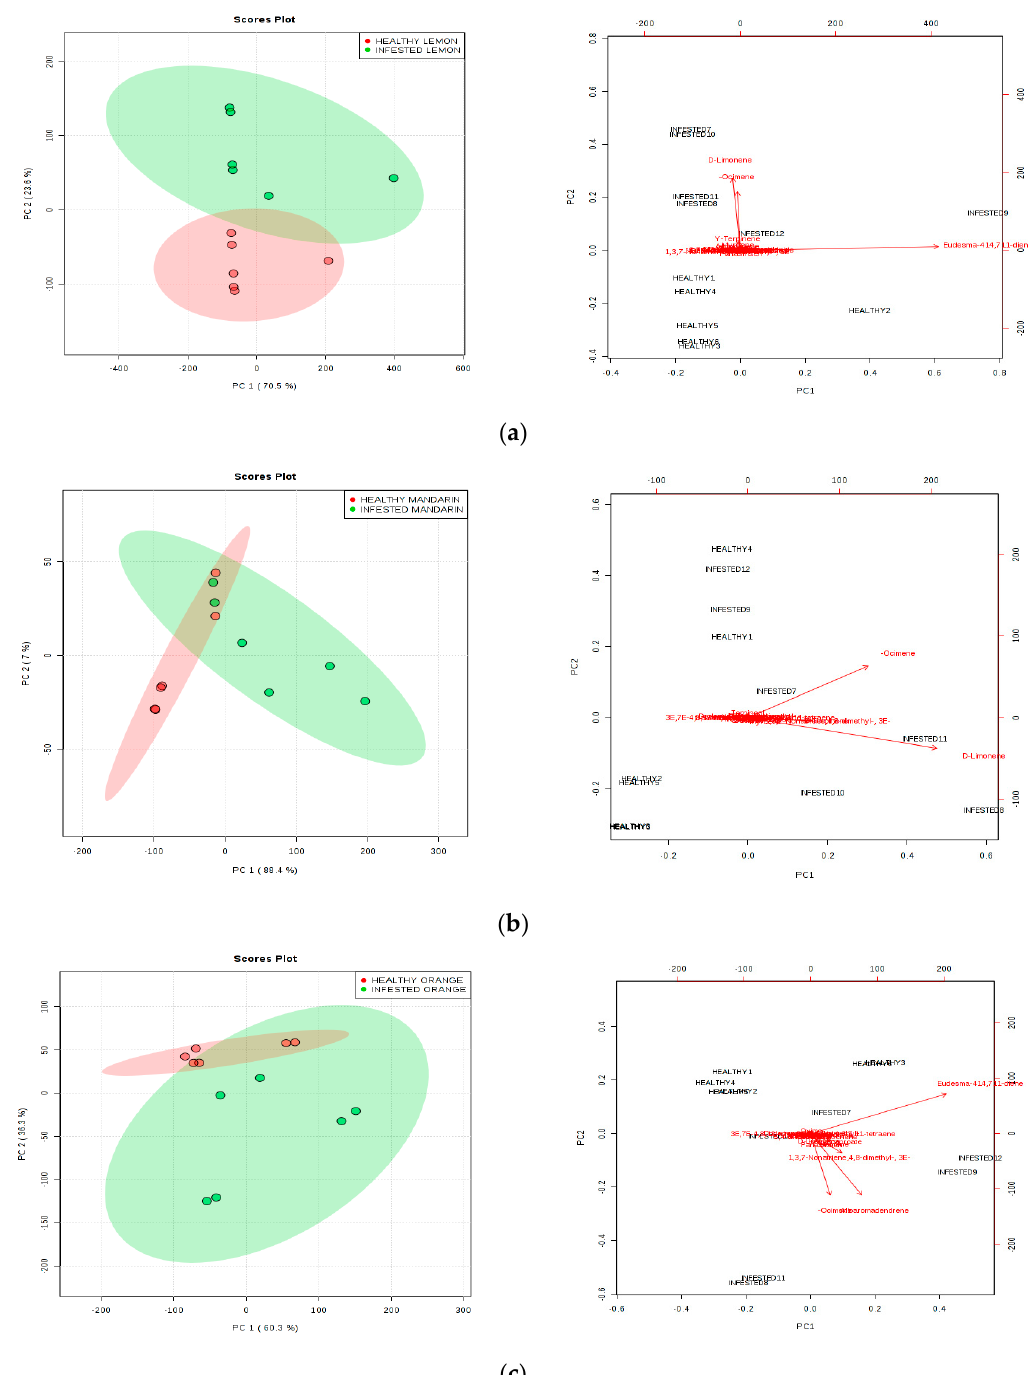
Figure 1. Principal Component Analysis (PCA) of volatile profiles from infested and non-infested fruit of three different citrus species. PCA scores plot and biplot of lemon ( a ), mandarin ( b ) and orange fruit ( c ), showing volatile correlations with the first and second principal component; PCA score plot, highlighting cluster of VOCs attributable to species or infestation status; PCA biplot highlighting changes in chemicals attribute to species or infestation status.